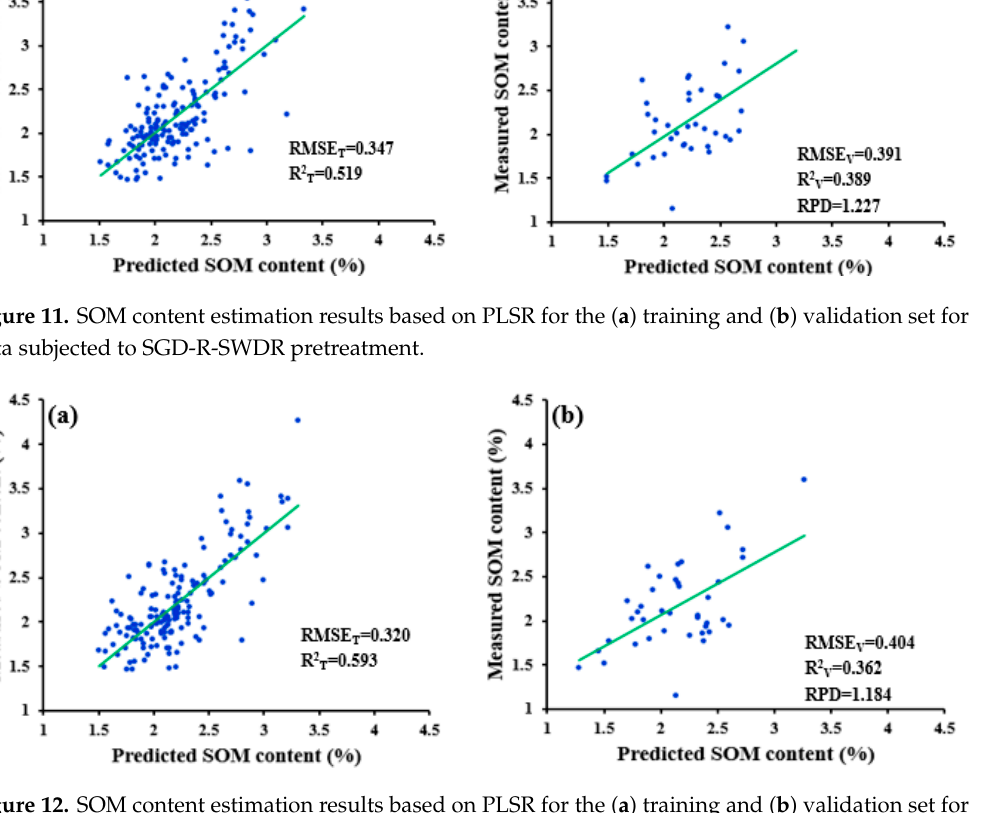
Figure 12. SOM content estimation results based on PLSR for the ( a ) training and ( b ) validation set for data subjected to WPD-R-SWDR pretreatment.